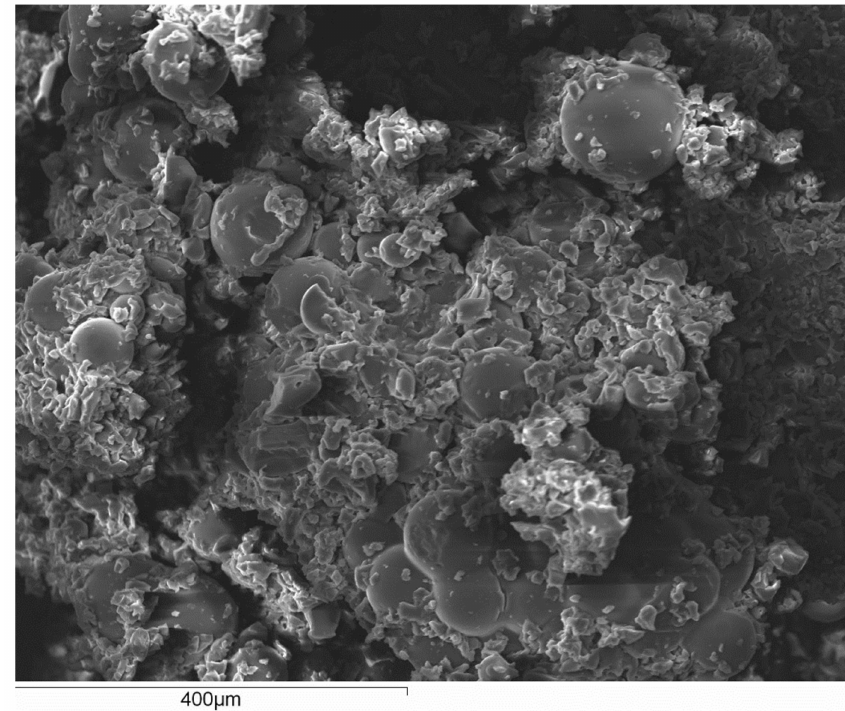
Figure A3. SEM image of PEGMA-AMP-Boc-3 (magnification × 150).